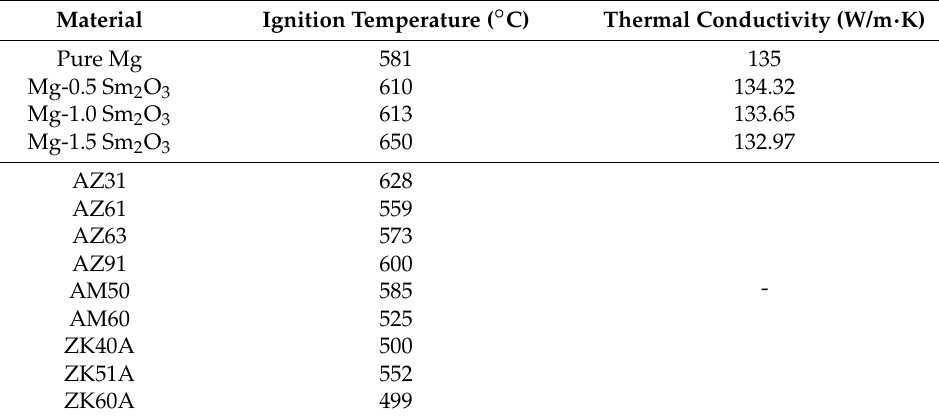
Table 3. Results of ignition temperatures